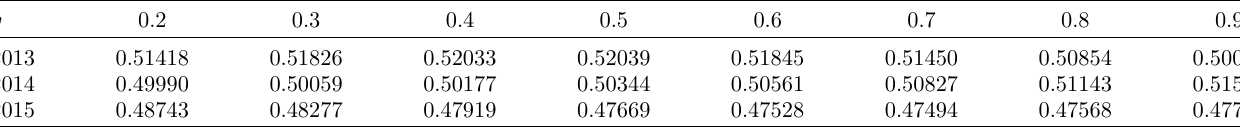
Figure 7. ^ E ð U j V > v Þ according to equation (4) for v 2 ½ 0 ; 1 (cid:3) ; years: 2013, 2014 and 2015. ^ E Table 4. ð U j V > v Þ according to equation (4), years 2013, 2014 and 2015.